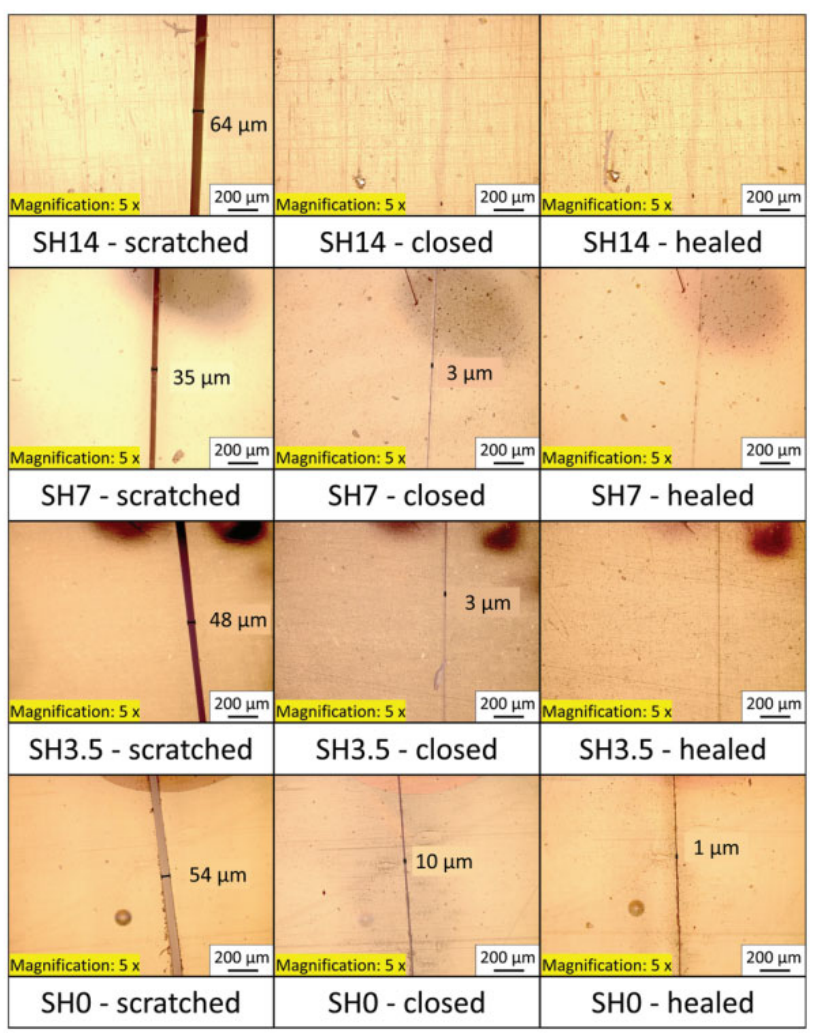
Figure 6. Morphological investigation of the SMASH performance of the selected networks via optical microscopy. The samples were monitored as‐scratched, recovered (closed), and after healing at 180 °C for 5 h [117].